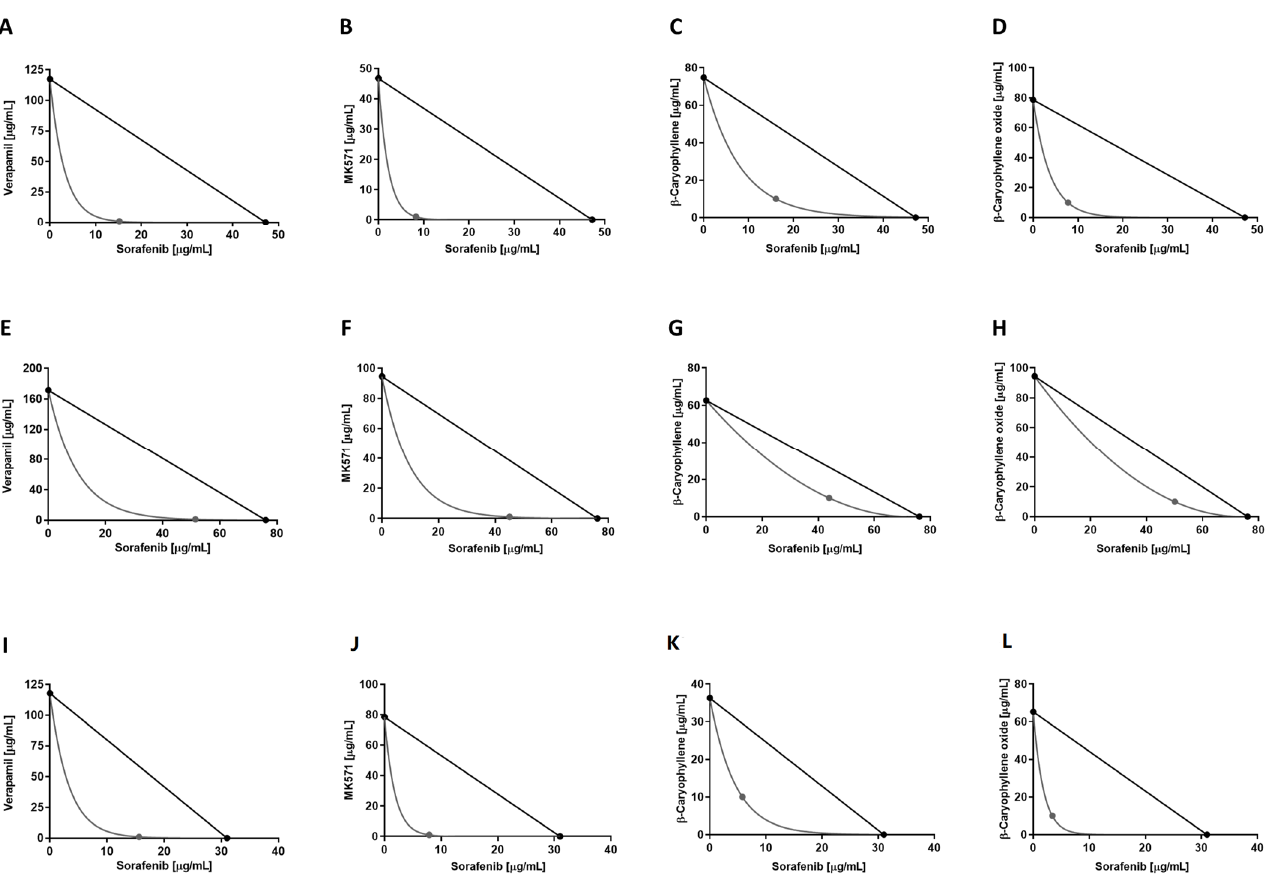
Figure 4. Isobolographic analysis of the cytotoxic effect of sorafenib in combination with verapamil and MK571 (1 µg/mL), and with β -caryophyllene and β -caryophyllene oxide (10 µg/mL) in HepG2